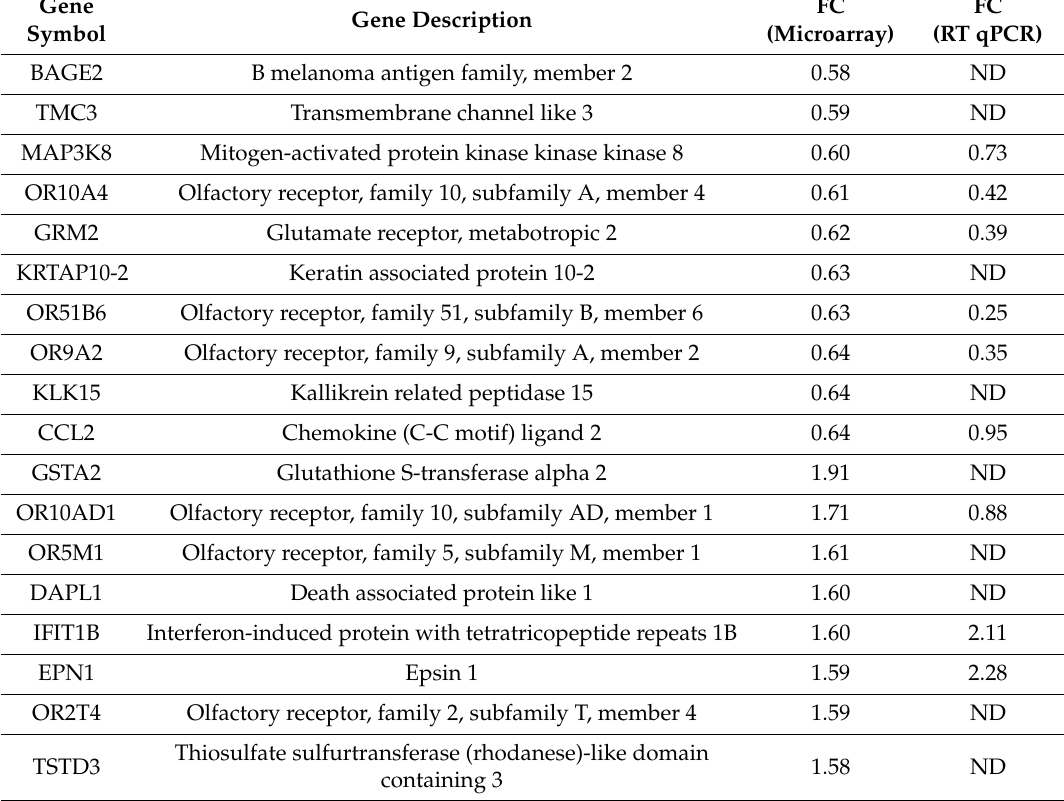
Di ff erentially expressed genes between the preformed fibril (PFF)-treated and phosphate-bu ff ered saline (PBS_-treated RPMI-2650 cells (top upregulated and downregulated genes; see Table S2 for the complete